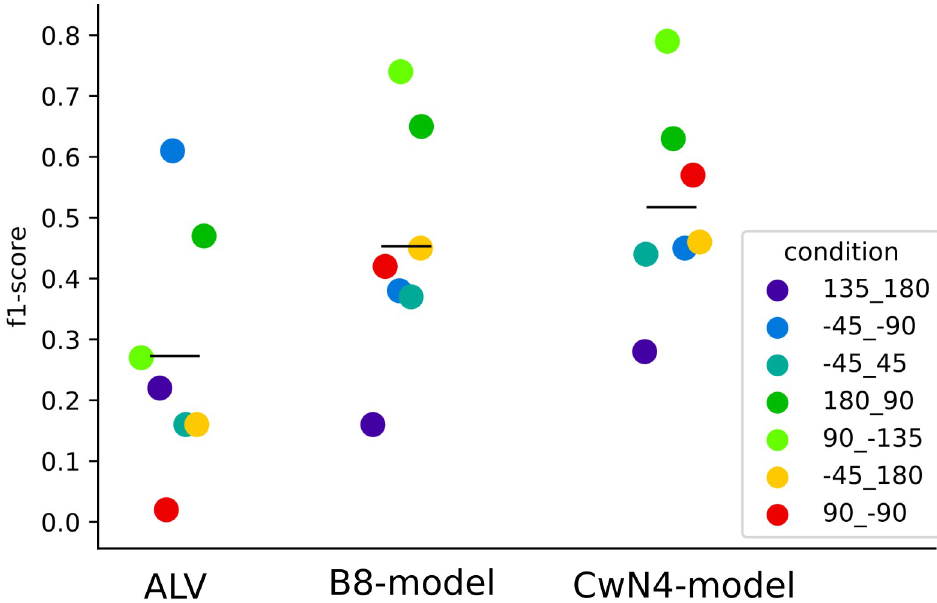
Fig 7. Quantitative comparison of models and behaviour during conflict situations. Distribution of F1-scores indicating the accuracy of the models prediction for each conditions describe with a colour code. The horizontal black bars represent the mean of the F1-score per